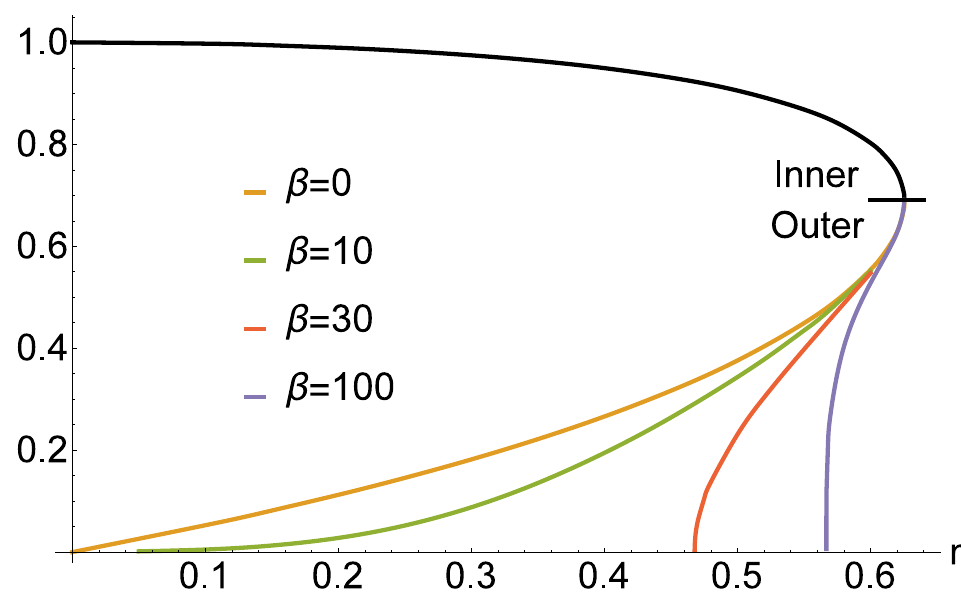
Figure 3 . The inner (top) and outer (bottom) bounds as a function of mass, measured by the radial coordinate z , of the electron cloud for charge Q 2 = 4 and di(cid:11)erent (cid:12) . Note especially that the inner bound is independent of (cid:12) and that for a speci(cid:12)c mass, only values of m > m crit ( Q; (cid:12) ) gives a well de(cid:12)ned outer